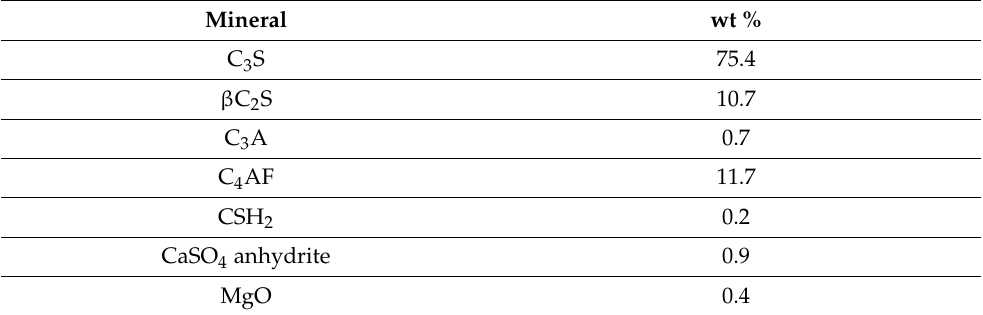
Figure 1. Particle size distribution of the aggregate and cumulative sieving curve of concrete. Table 1. The mineral composition of CEM I 42.5 R cement based on the X-ray diffraction pattern